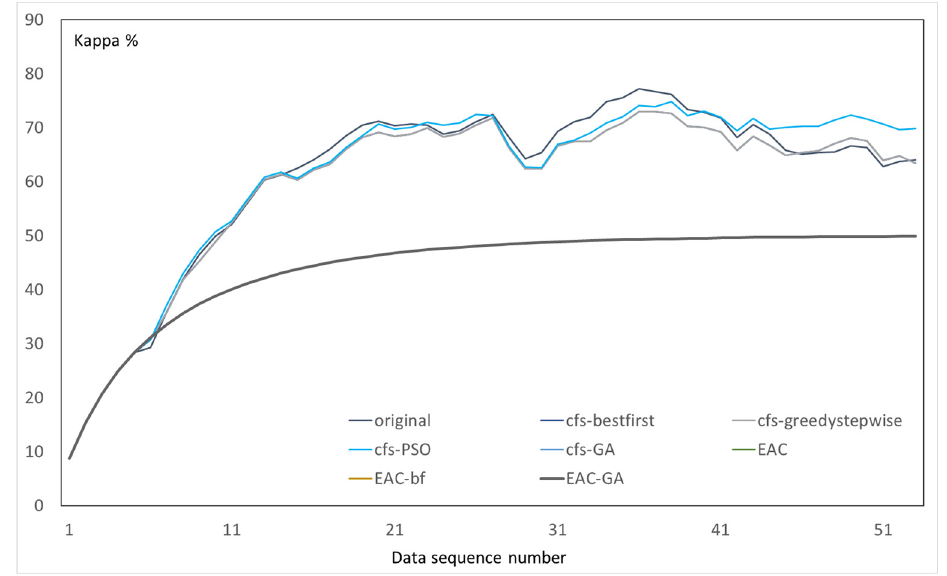
Figure 8. Comparative graph of Kappa of the Hoeffding tree model coupled with seven preprocessing algorithms.